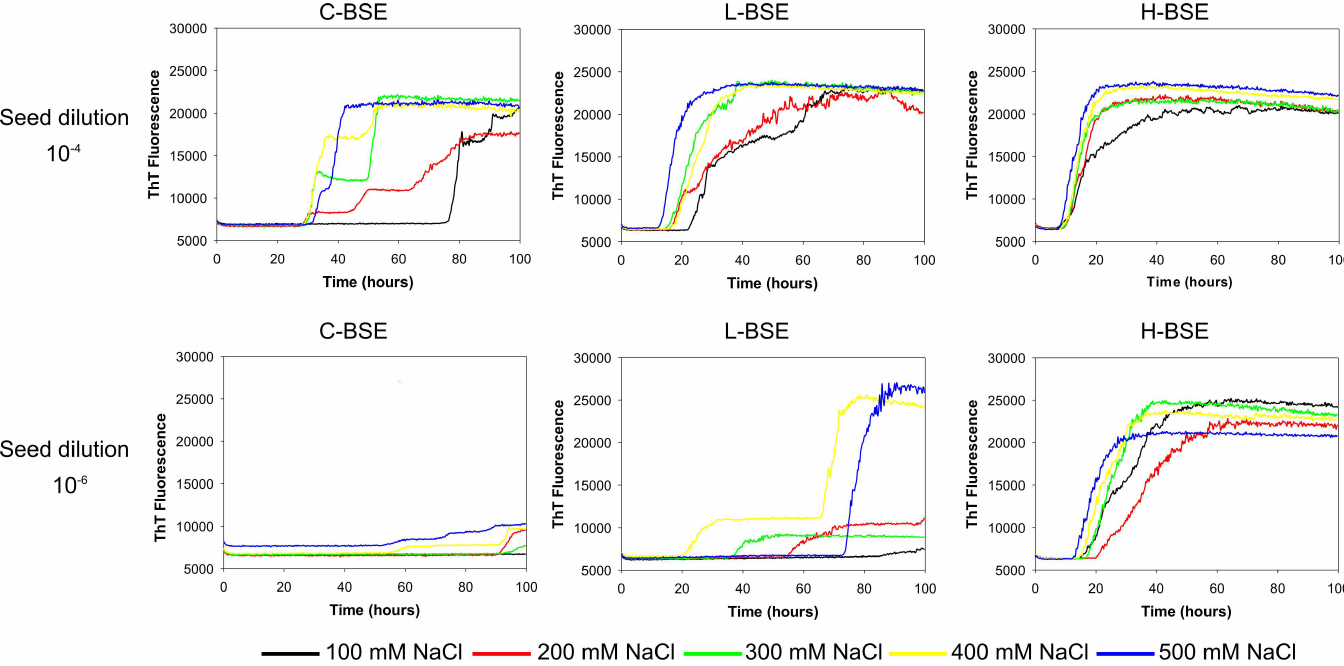
Fig 5. RT-QuIC sodium chloride titration for different types of BSE-infected cattle brain samples. RT-QuIC reactionswere seededwith 10 − 4 and 10 − 6 dilutionof C-, L, and H-BSE-infected cattle brain homogenates using a range of NaCl concentrations (100–500mM) with the full-lengthbPrP wild type (aa 25– 241) as substrate. Data are presented as mean ThT fluorescence of 8 reactions conductedas 2 repeats of 4 reactions. The positive threshold was calculate as ~10,000relativefluorescence units of normal cattle brain